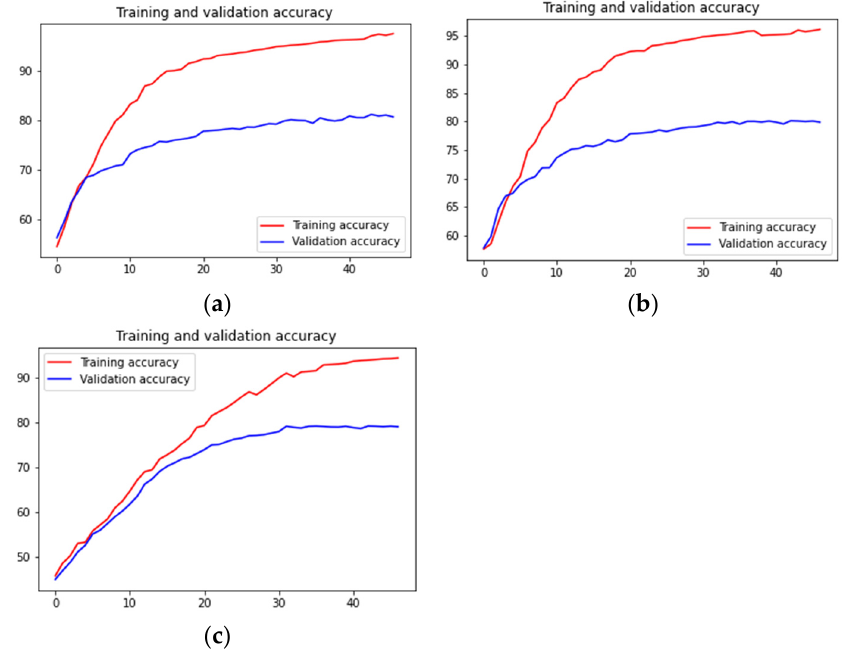
Figure 11. From top-left in a clockwise manner: training accuracy and validation accuracy vs. number of epochs of fine-tuned ( a ) VGG-16 model, ( b ) VGG-19 model, and ( c ) Inception-ResNet v2 model.